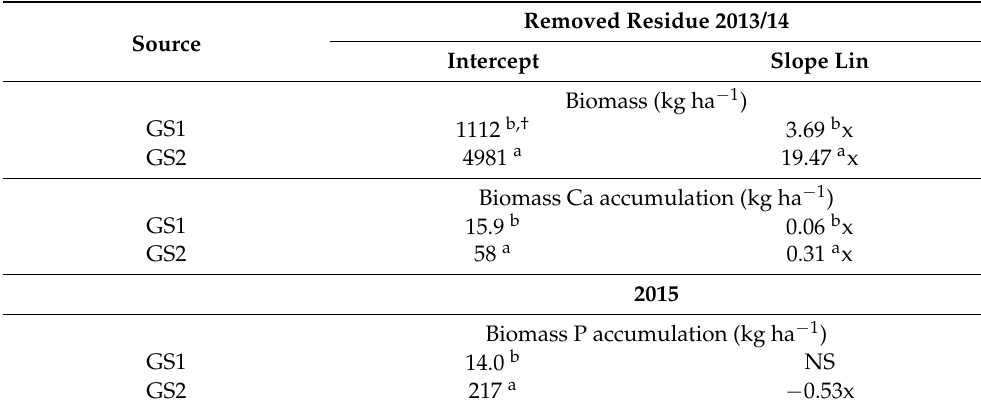
Table A5. Biomass accumulation, biomass Ca accumulation in 2013 and 2014, and biomass P accumulation in 2015 as a function of N rates and growth stages.